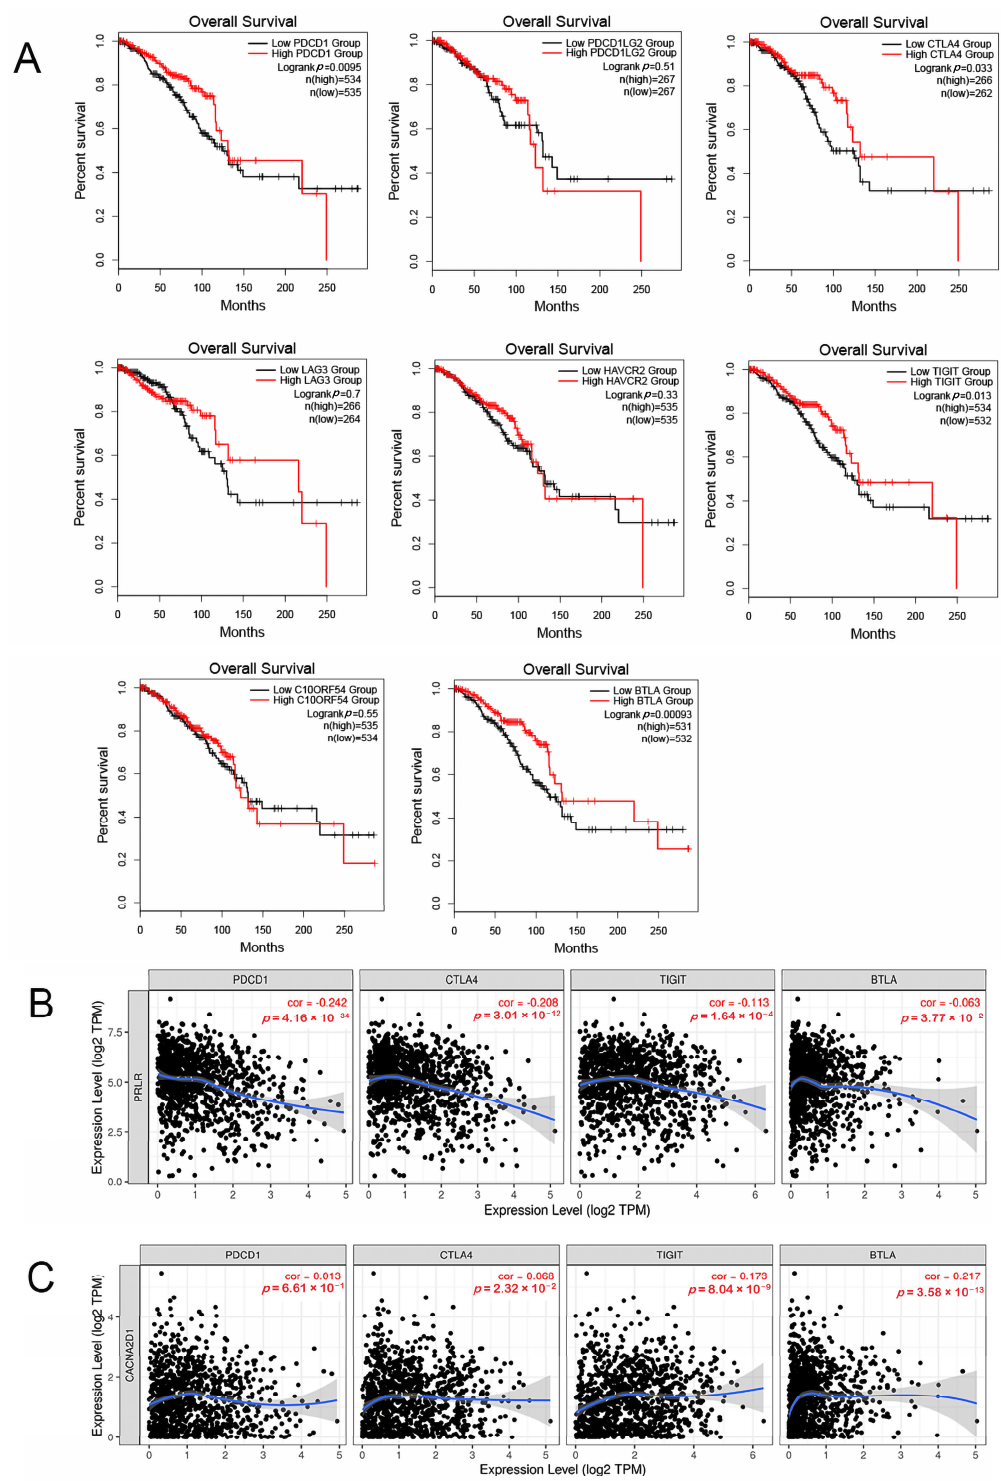
Figure 12. ( A ) Kaplan–Meier plots were used to analyze the immune checkpoints and overall sur- vival rate of BRCA. ( B ) Relationship between immune checkpoints and PRLR expression. ( C ) Rela- tionship between immune checkpoints and CACNA2D1 expression.